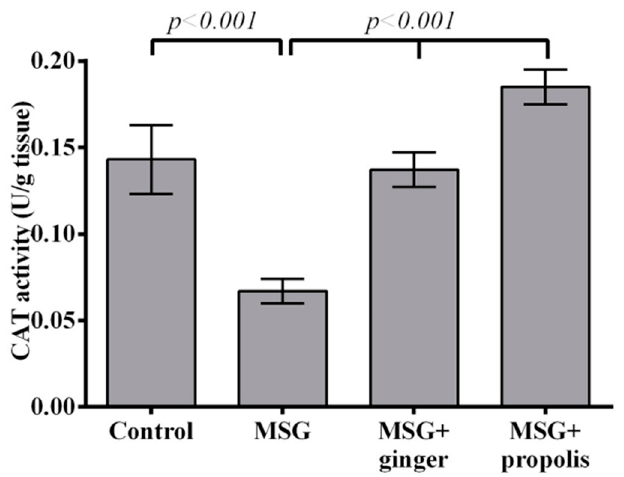
Figure 9. Effects of aqueous extract of ginger and propolis on Cat enzyme activity in the brain tissue of various experimental groups. Data are expressed as mean ± SEM ( n = 6). Comparisons were made between normal control and MSG control groups, and also between MSG control and MSG plus ginger or propolis supplement groups.